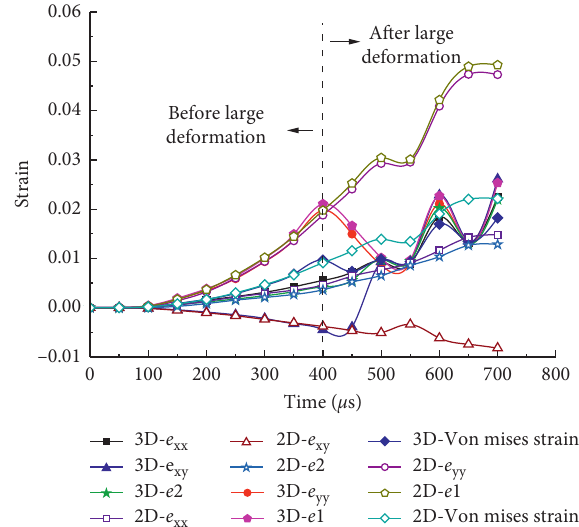
Figure 12: Comparison of 3D-DIC and 2D-DIC analysis with time increases for test